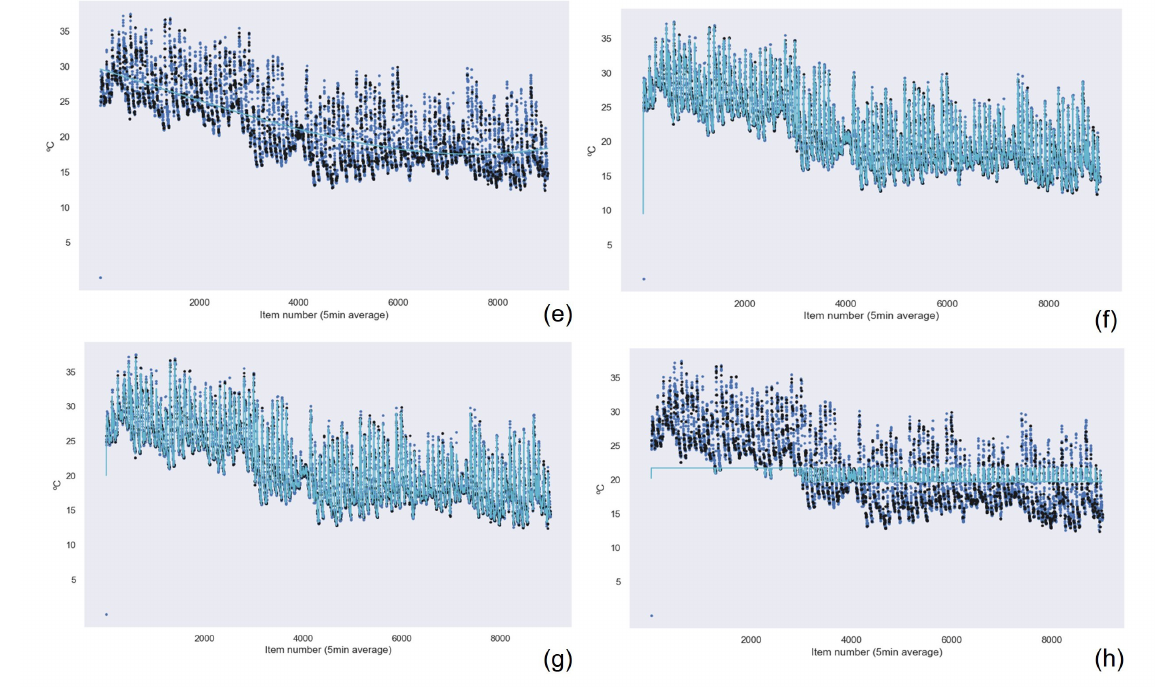
Figure A18. Temperature results of the articulate matter measuring device # 2 with outliers for ( a ) Linear Regression ( b ) Random Forest Regression ( c ) KNN and ( d ) Support Vector Machine, and without outliers for ( e ) Linear Regression ( f ) Random Forest Regression ( g ) KNN and ( h ) Support Vector Machine.